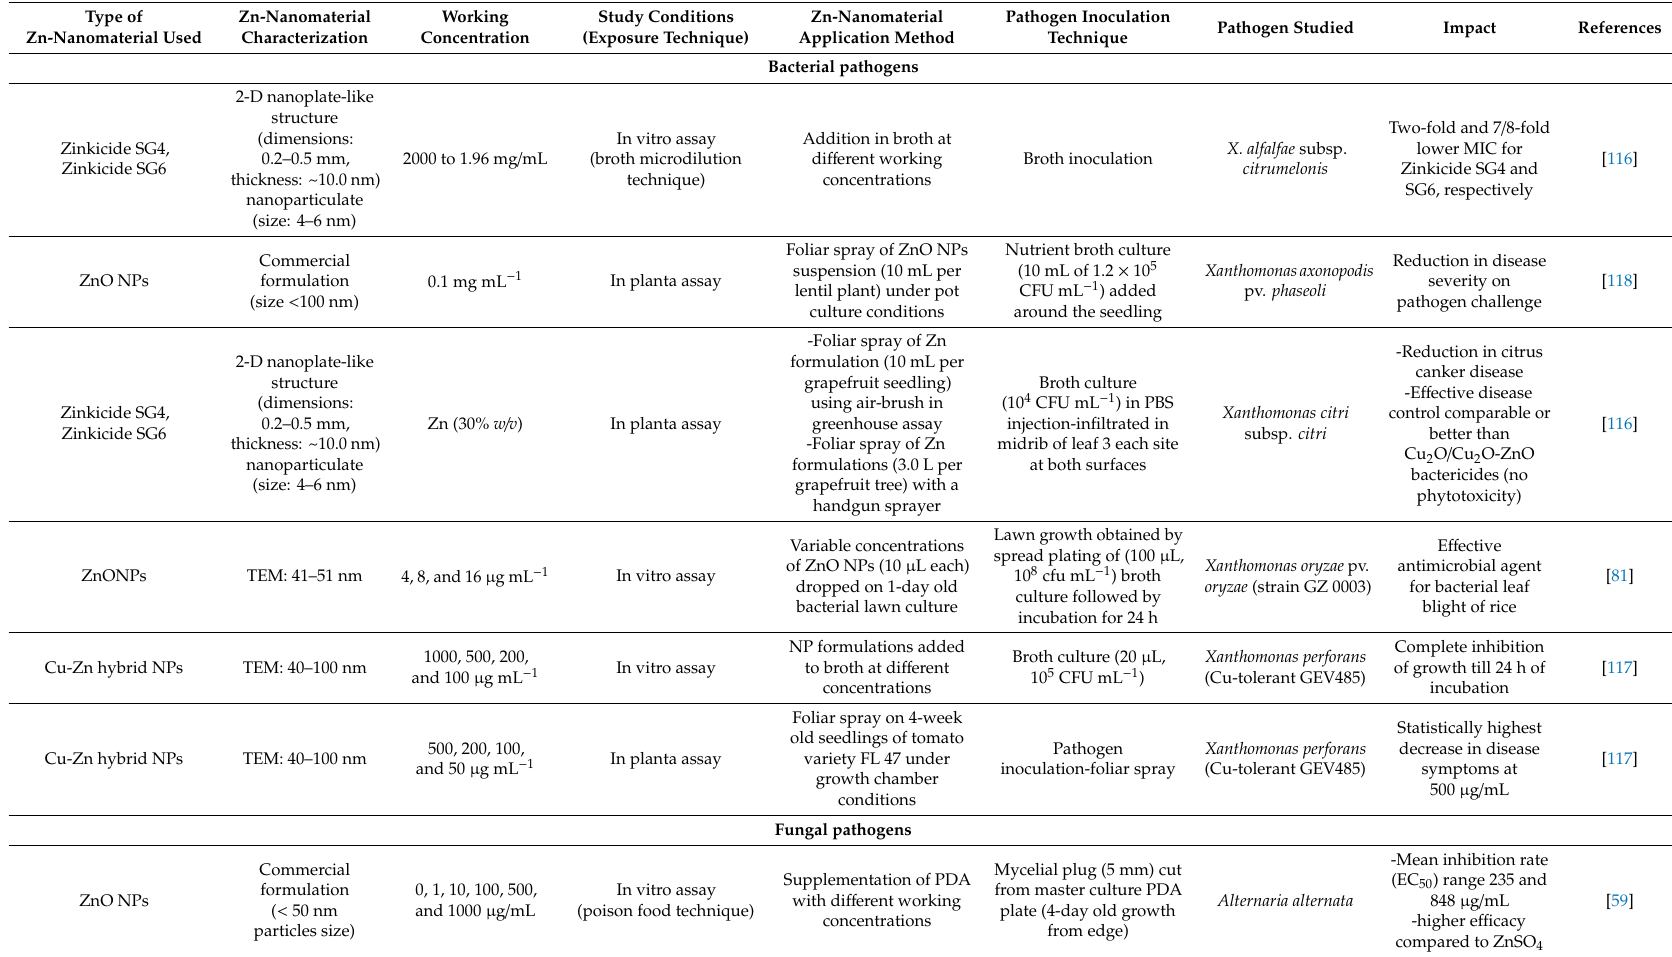
Table 1. Antimicrobial potential of zinc nanomaterials on plant pathogenic